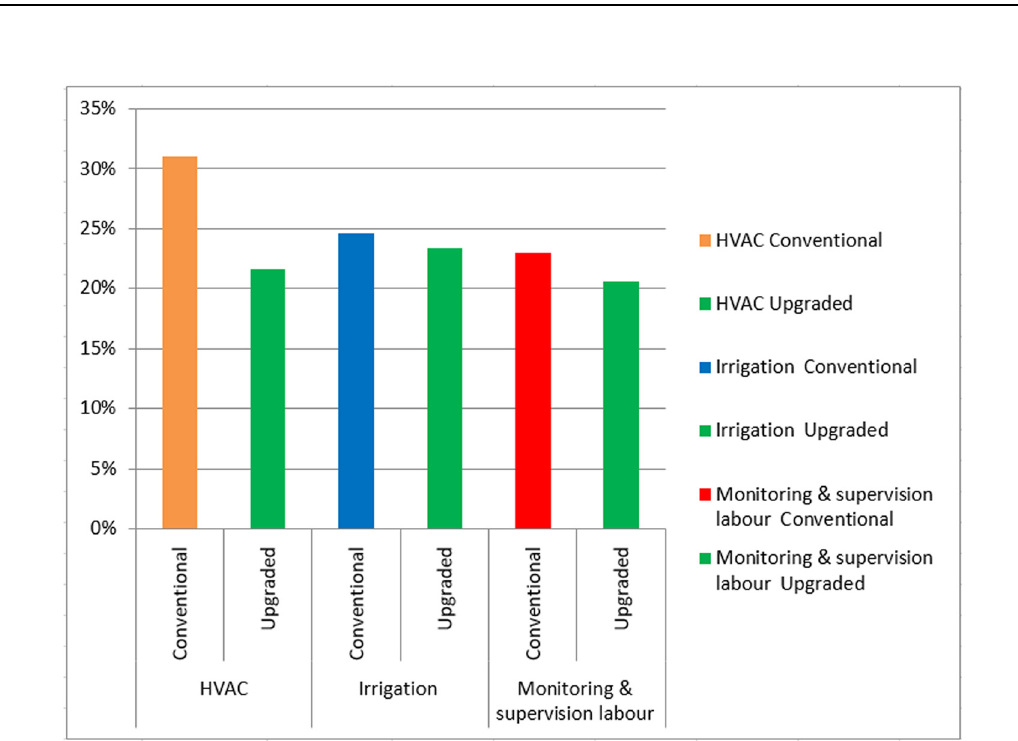
Figure 15: Energy expenditure comparison before and after upgradation on major heads.